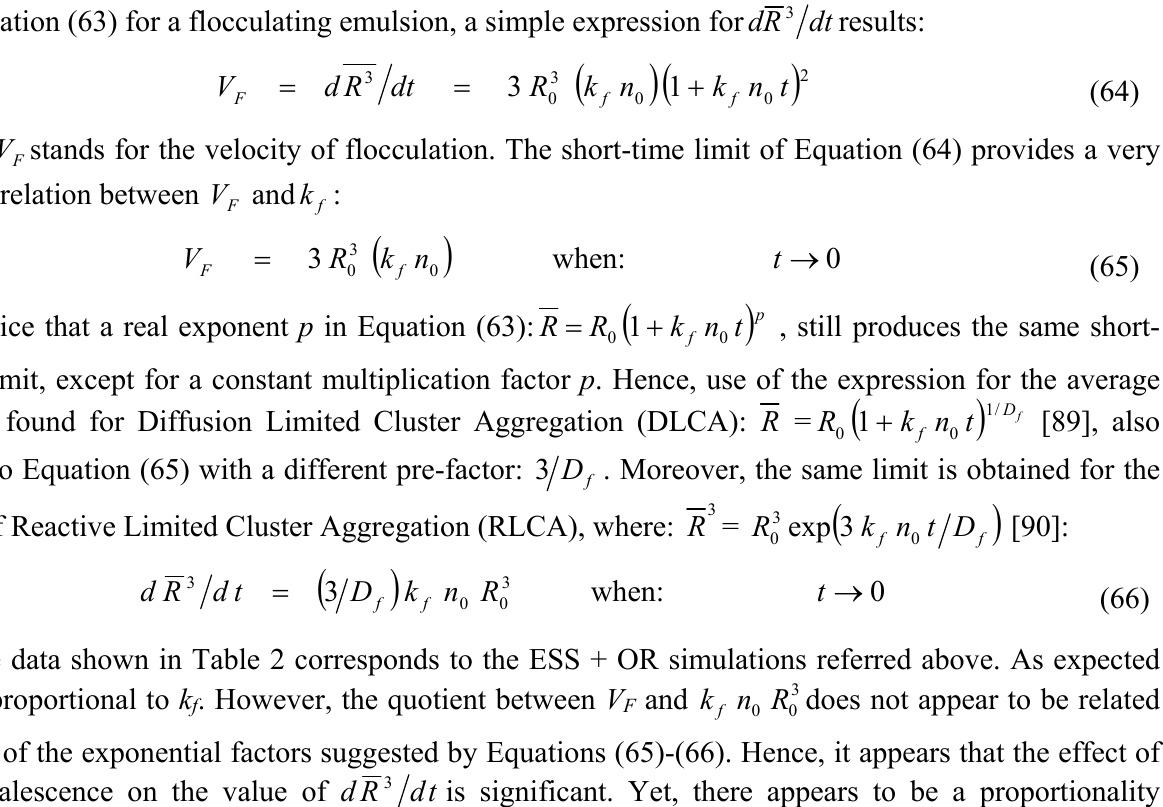
Table 2. Relationship between k